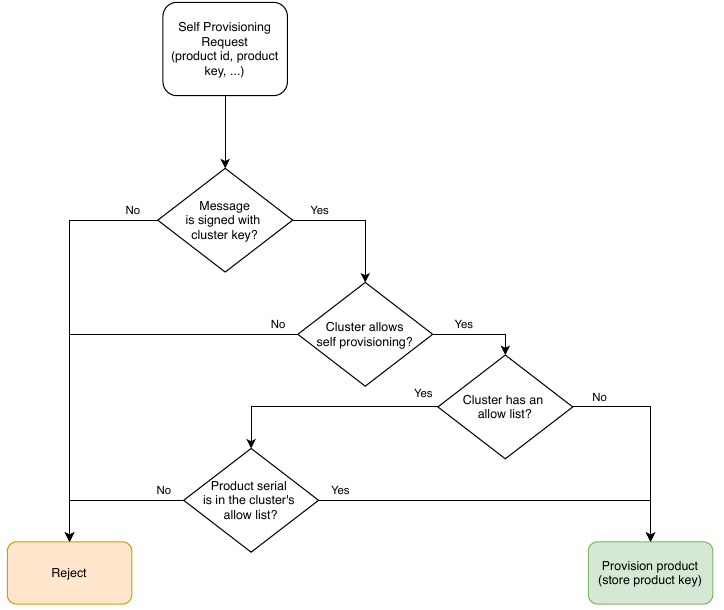
Figure 6. A flowchart showing the product self provisioning at the